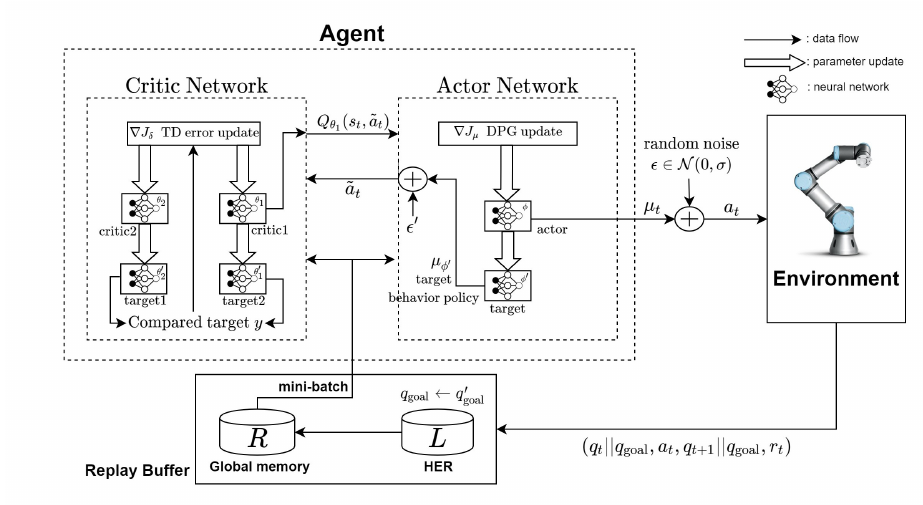
Figure 2. Structure of TD3 (Twin Delayed Deep Deterministic Policy Gradient) with